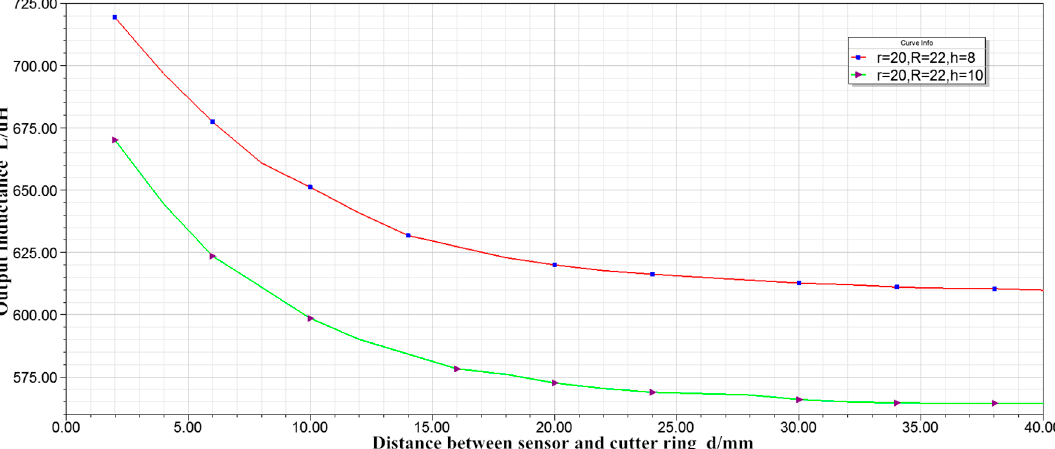
Figure 8. Characteristic curve of inductance displacement.